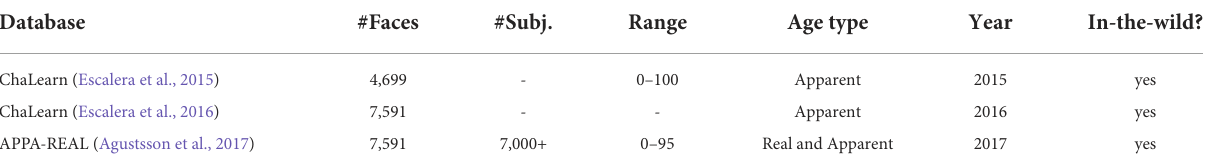
TABLE 3 A summary of apparent age estimation databases.